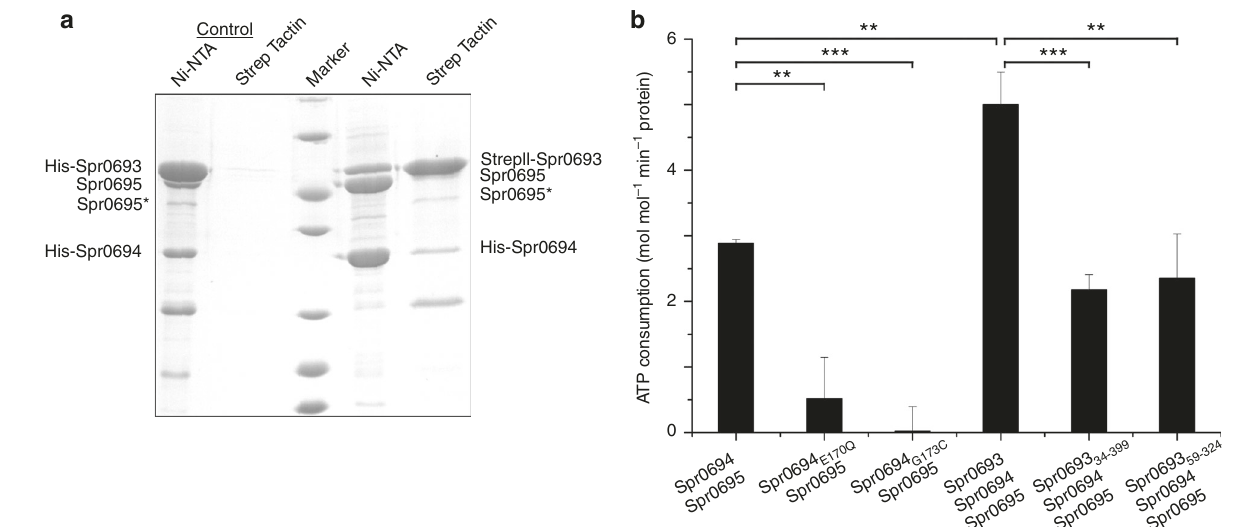
Fig. 3 Spr0693 interacts with Spr0694 – 0695 and augments the ATPase activity. a Pull-down assays. His-tagged Spr0694 and Strep-tag II tagged Spr0693 were mixed and subjected to Ni-NTA followed by Strep Tactin puri fi cation (last two lanes). The fi rst two lanes represent the negative control with His- tagged Spr0694 and His-tagged Spr0693. The eluates of Ni-NTA and Strep Tactin were shown on the PAGE. Spr0695* represents a partially degraded fragment of Spr0695, as con fi rmed by mass spectrometry (Supplementary Figure 2). The protein marker presented seven bands from bottom to top (14.4, 18.4, 25, 35, 45, 66.2, 116 kDa). b The ATPase activities of Spr0694 – 0695, Spr0693 – 0694-0695, and mutants. Activity assays were performed in the proteoliposomes. For each reaction, 0.2 μ M Spr0694 – 0695 (or mutants) dimer and/or 0.4 μ M Spr0693 (or mutants) hexamer were added to the 100 μ L reaction mix. The V max values were calculated by the Pi produced in mole with the consumption of ATP by per mole of Spr0694 – 0695 protein per minute. At least three independent assays were performed to calculate the means and standard deviations, and the data are presented as the means ± S.D. Two-tailed Student ’ s t test is used for the comparison of statistical signi fi cance. The p values of < 0.05, 0.01 and 0.001 are indicated with *, ** and